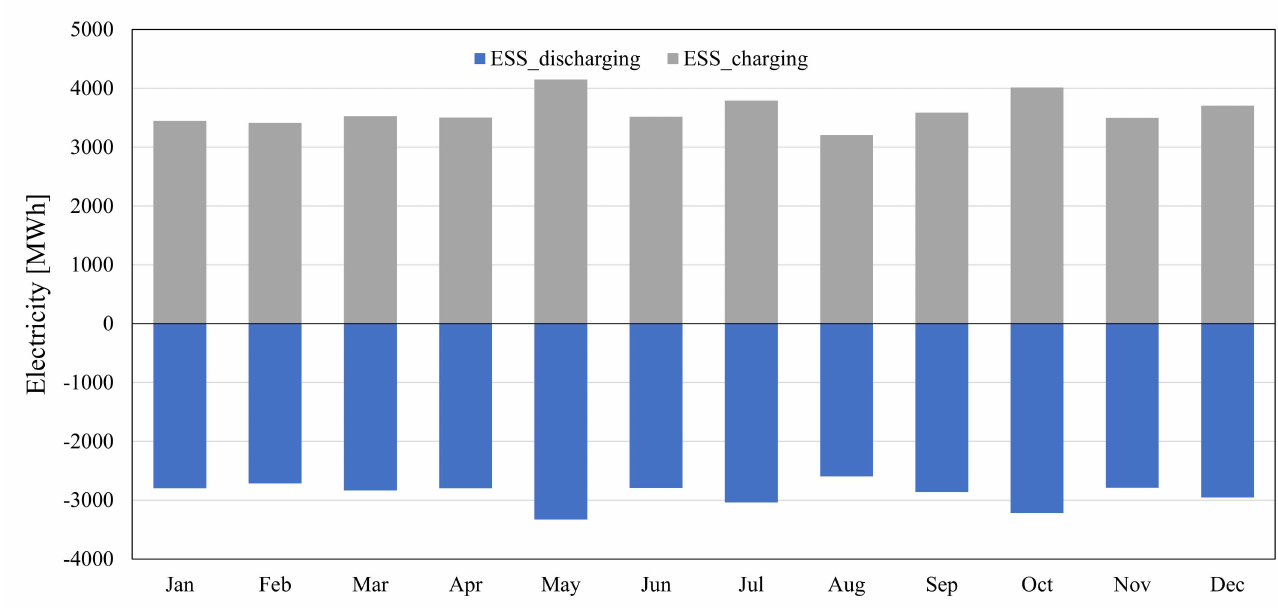
Figure 7. Operation profile of NG generator in base case: ( a ) monthly electricity balance, ( b ) monthly thermal balance, ( c ) hourly electricity balance, ( d ) hourly thermal balance.